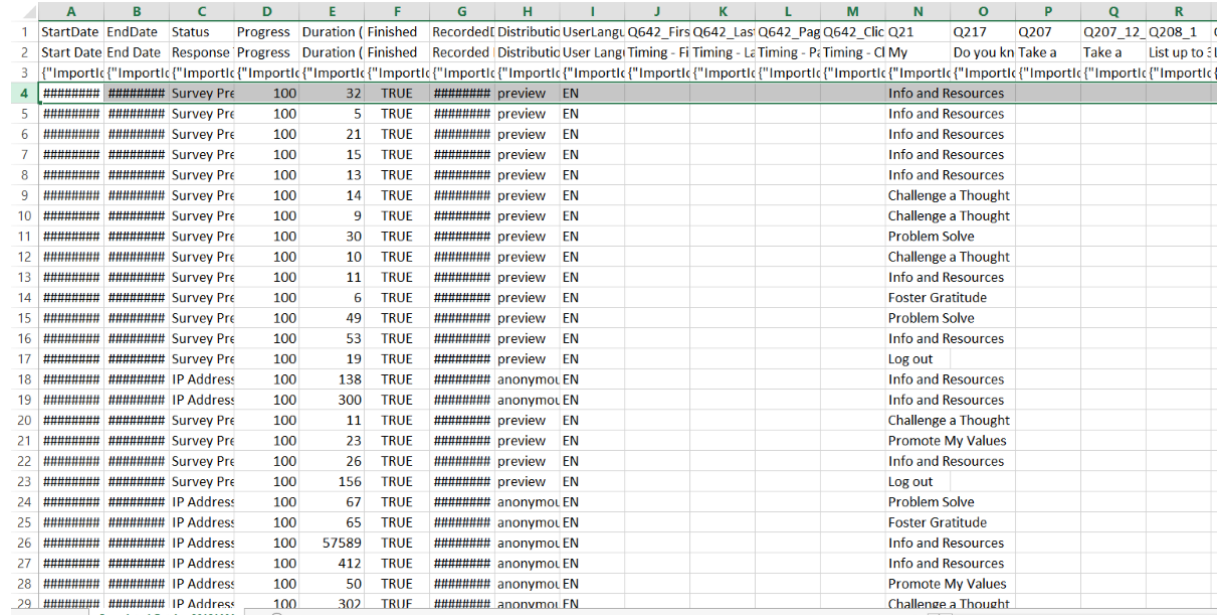
Figure 6. Screenshot of a hypothetical data